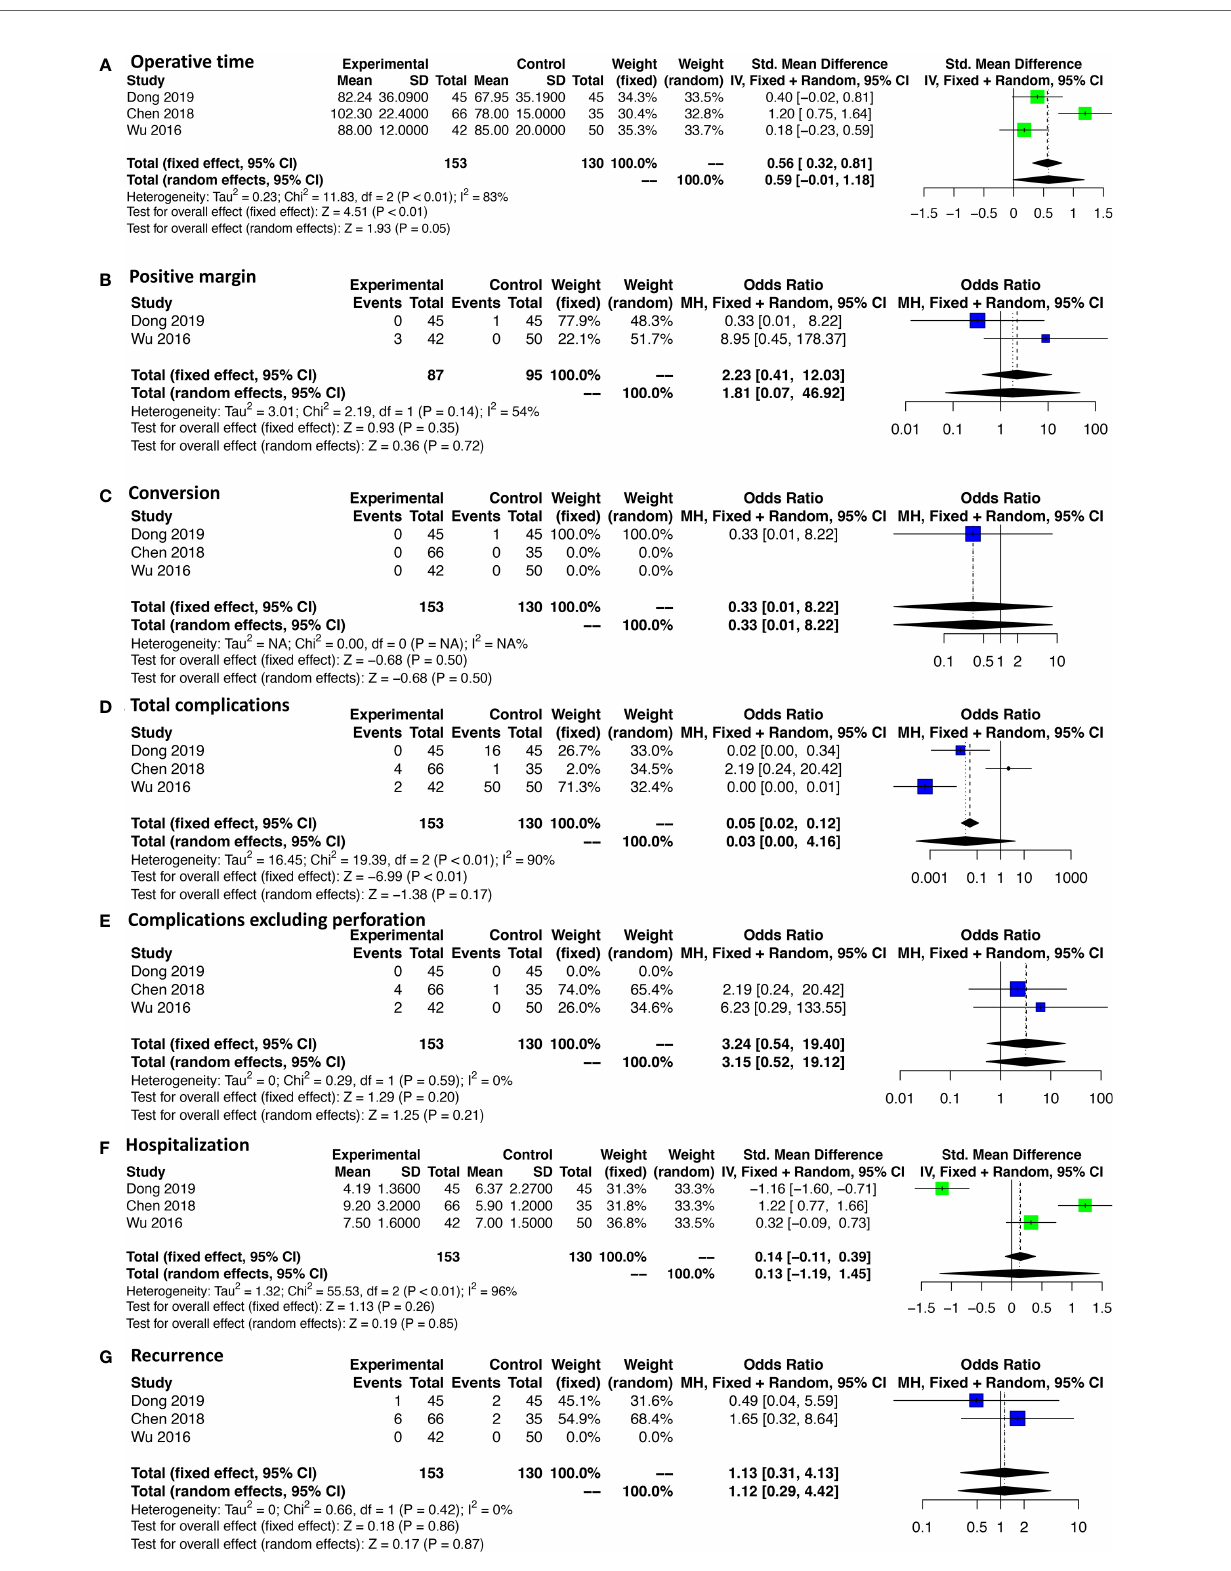
FIGURE 6 | est plots illustrating the results of the subgroup analysis (tumor size 2-5cm). The (A) operative time, (B) positive margin rate, (C) conversion rate, (D) total complications, (E) complications excluding perforation, (F) hospitalization and (G) recurrence were analyzed respectively.